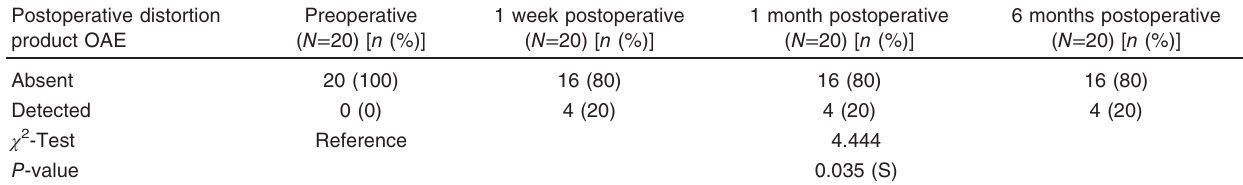
Table 2 Comparison between preoperative and postoperative distortion product otoacoustic emission Postoperative distortion product